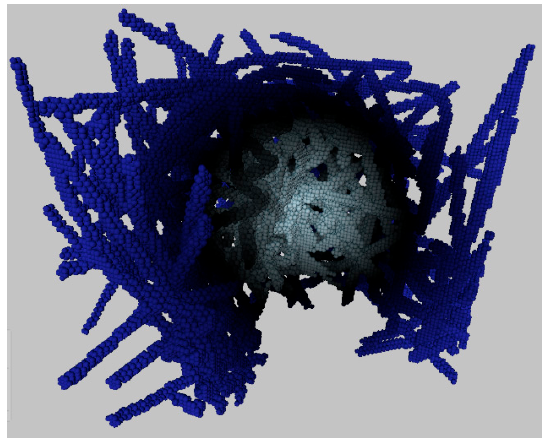
( b ) Figure 13. Creation a fiber with Bezier curve: